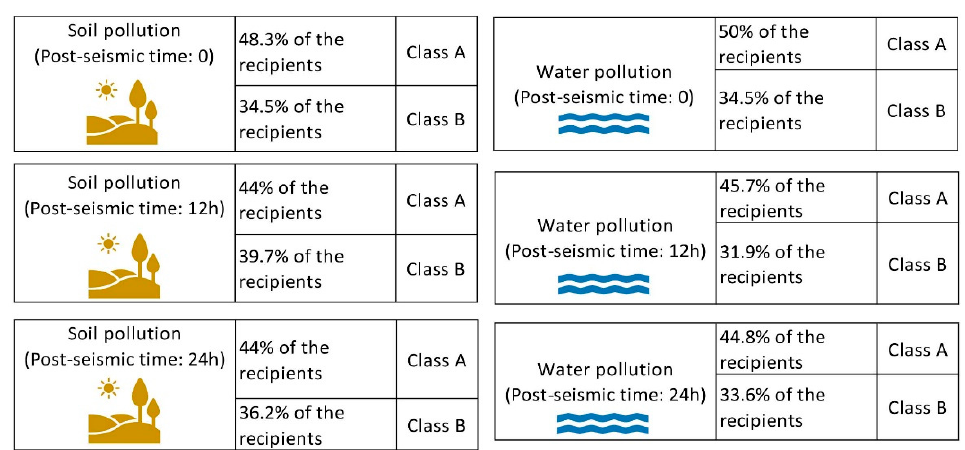
Figure 11. Estimation of soil–water pollution due to the potential release of contaminants from WWTPs during the post-seismic period.